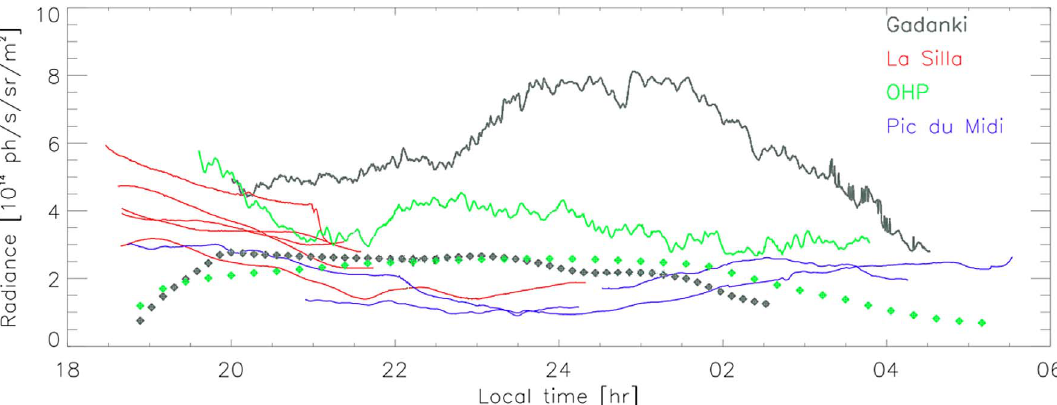
Fig. 8. Summary of the measurement campaigns (in solid lines) carried out by ONERA. Besides Gadanki and OHP (Fig. 7), campaigns have been performed at La Silla (Chile) and Pic du Midi (France). The crosses represent the evolution of the nightglow modeled at the